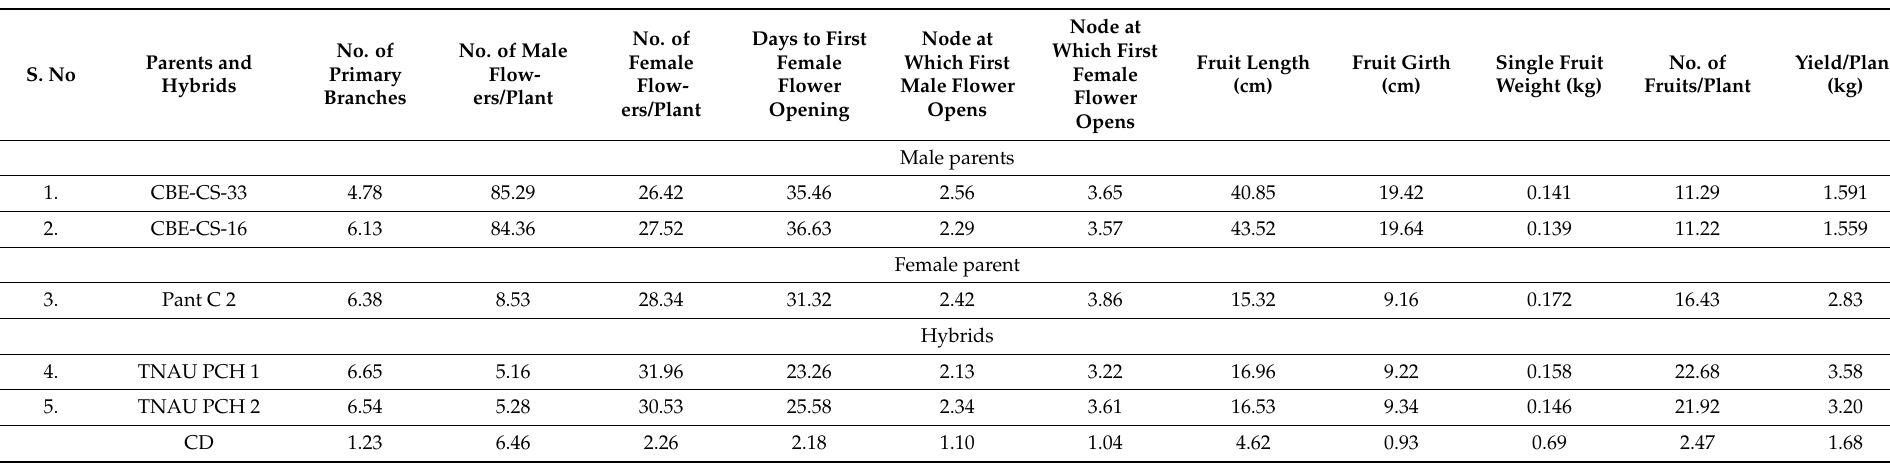
Table 2. Mean performance of parents and hybrids of cucumber investigated in this study, with three